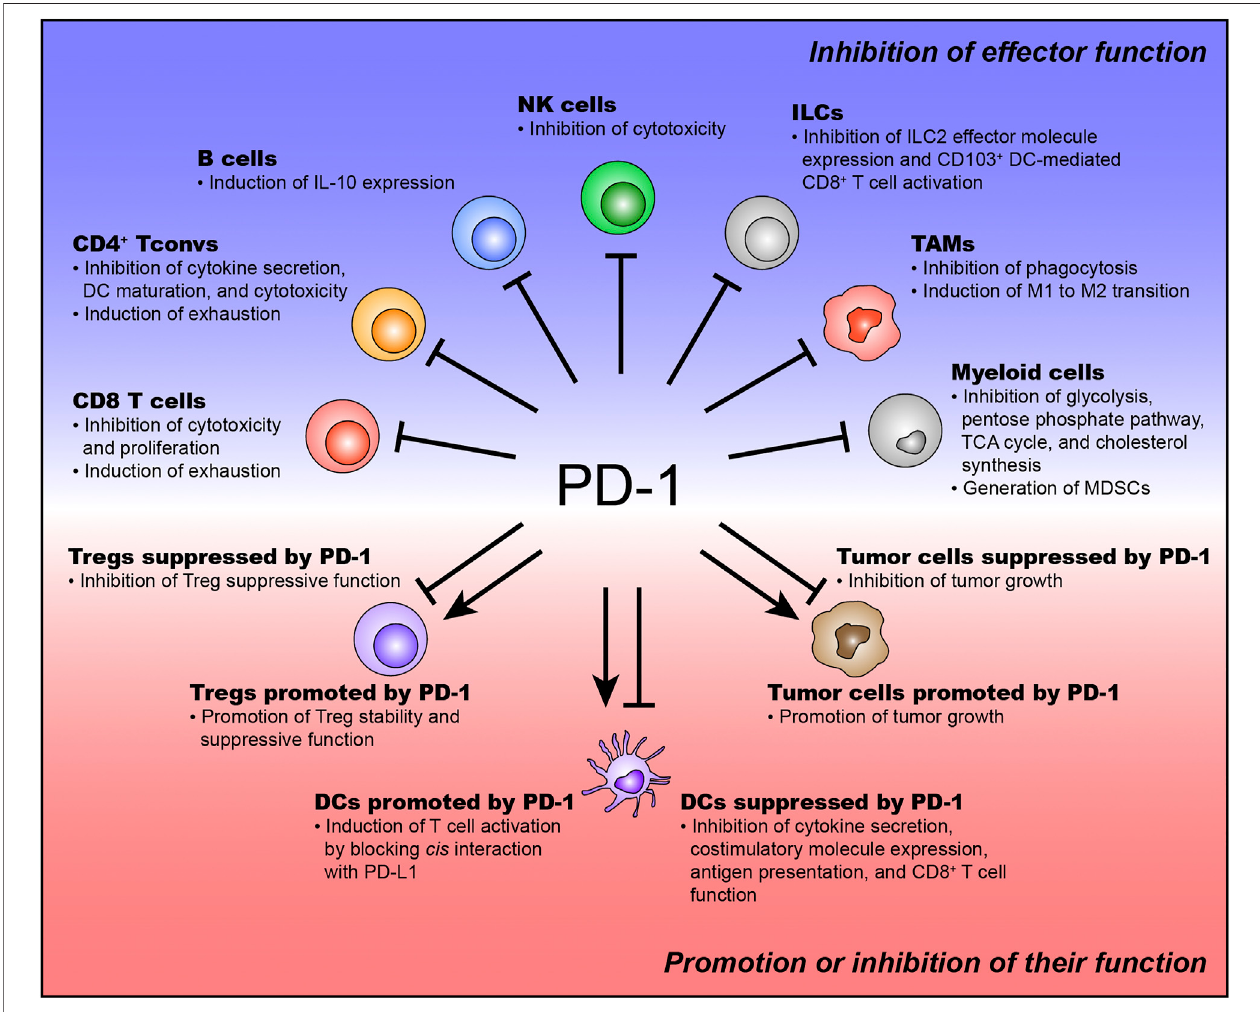
FIGURE 1 | The function of PD-1 expressed on various immune and tumor cells. PD-1 is expressed on various immune and tumor cells. PD-1 expressed on effector immune cells usually inhibits their effector function. The function of PD-1 expressed on suppressive immune cells and tumor cells has been controversial.